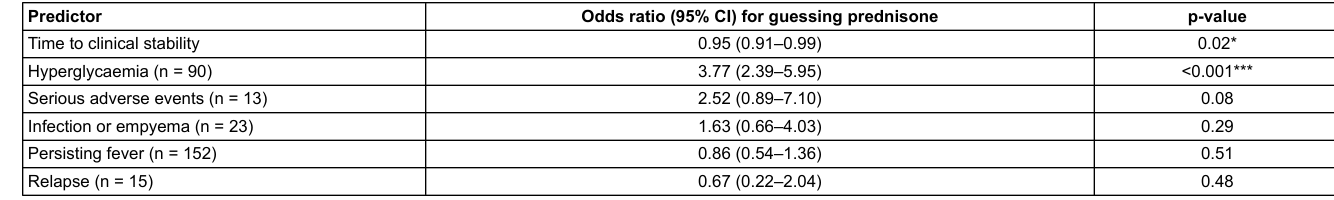
Table 2: Predictors for guessing prednisone.